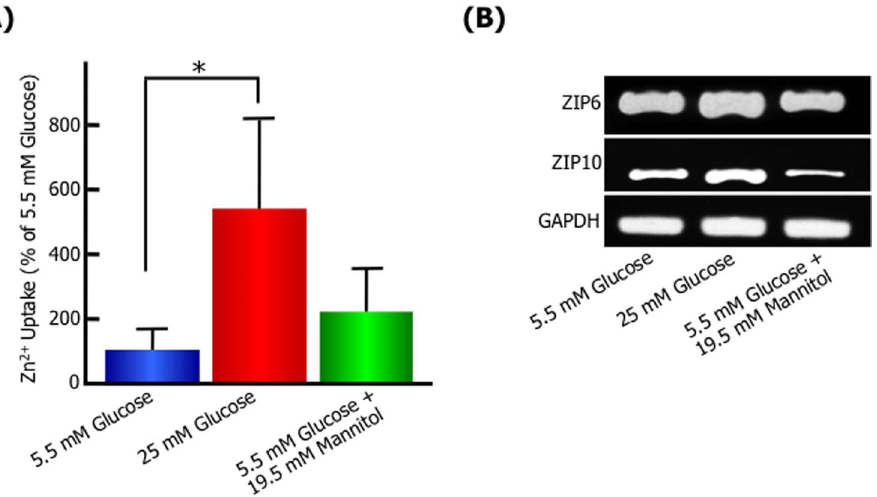
Figure 4. High glucose level induces intracellular Zn 2 + uptakes and mRNA expression of ZIP in MCF-7. MCF-7 cells were cultured with normal (5.5 mM), high (25 mM) D-glucose concentration, or an osmotic control (5.5 mM D-glucose plus 19.5 mM D-mannitol) medium. After 24 h, uptake of Zn 2 + in MCF-7 (A) and the changes in ZIP6 and ZIP10 mRNA levels in MCF-7 by RT-PCR (B) were analyzed. Data are presented as means 6 SD. * p , 0.05 versus control (5.5 mM glucose concentration), n=4–5.